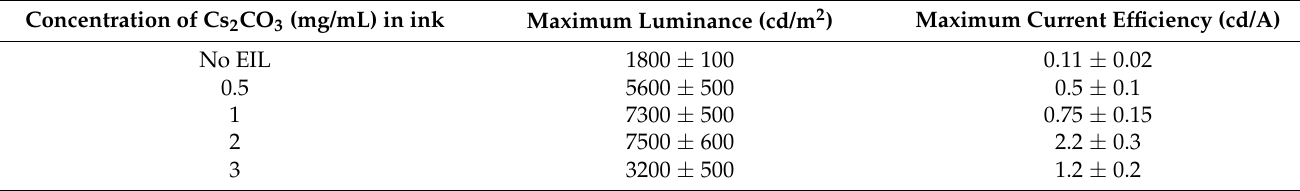
Table 2. Maximum luminance and maximum current efficiency of polymer organic light-emitting diodes (PLEDs), where EIL was printed with various Cs 2 CO 3 ink concentrations with resolution 500 dpi.